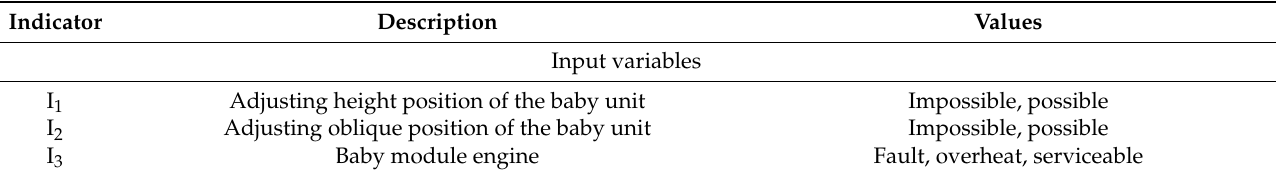
Table 2. Description of input and output